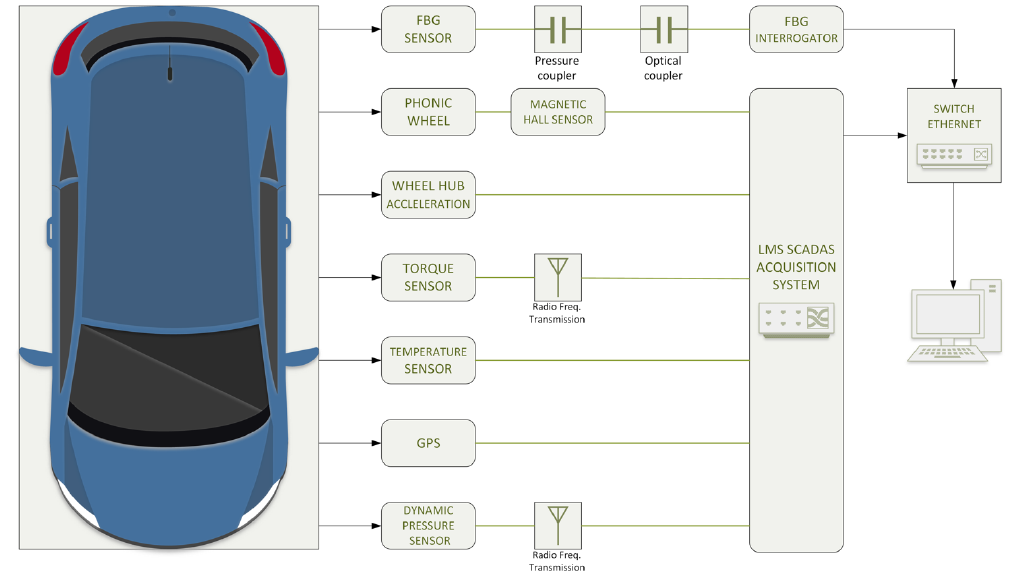
Figure 11. Sensing line conceptual scheme.